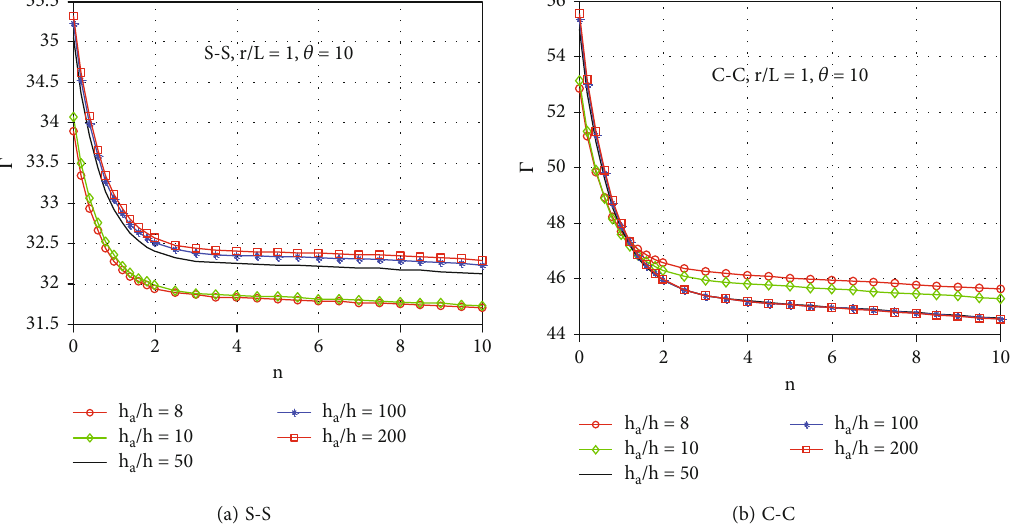
h and n , r / L = 1 , and θ = 10 a /